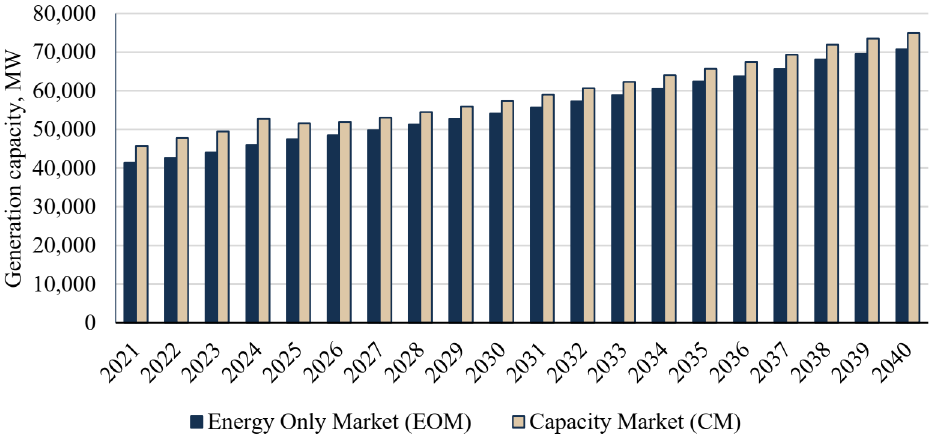
Figure 10. Generation capacity in the power system under the EOM and CM scenarios in